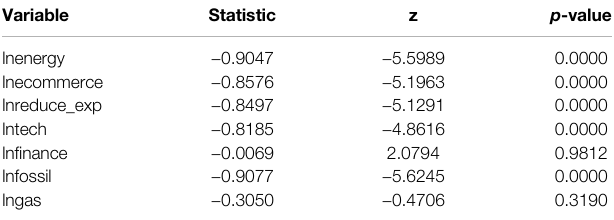
TABLE 3 | Harris-Tzavalis unit-root test.